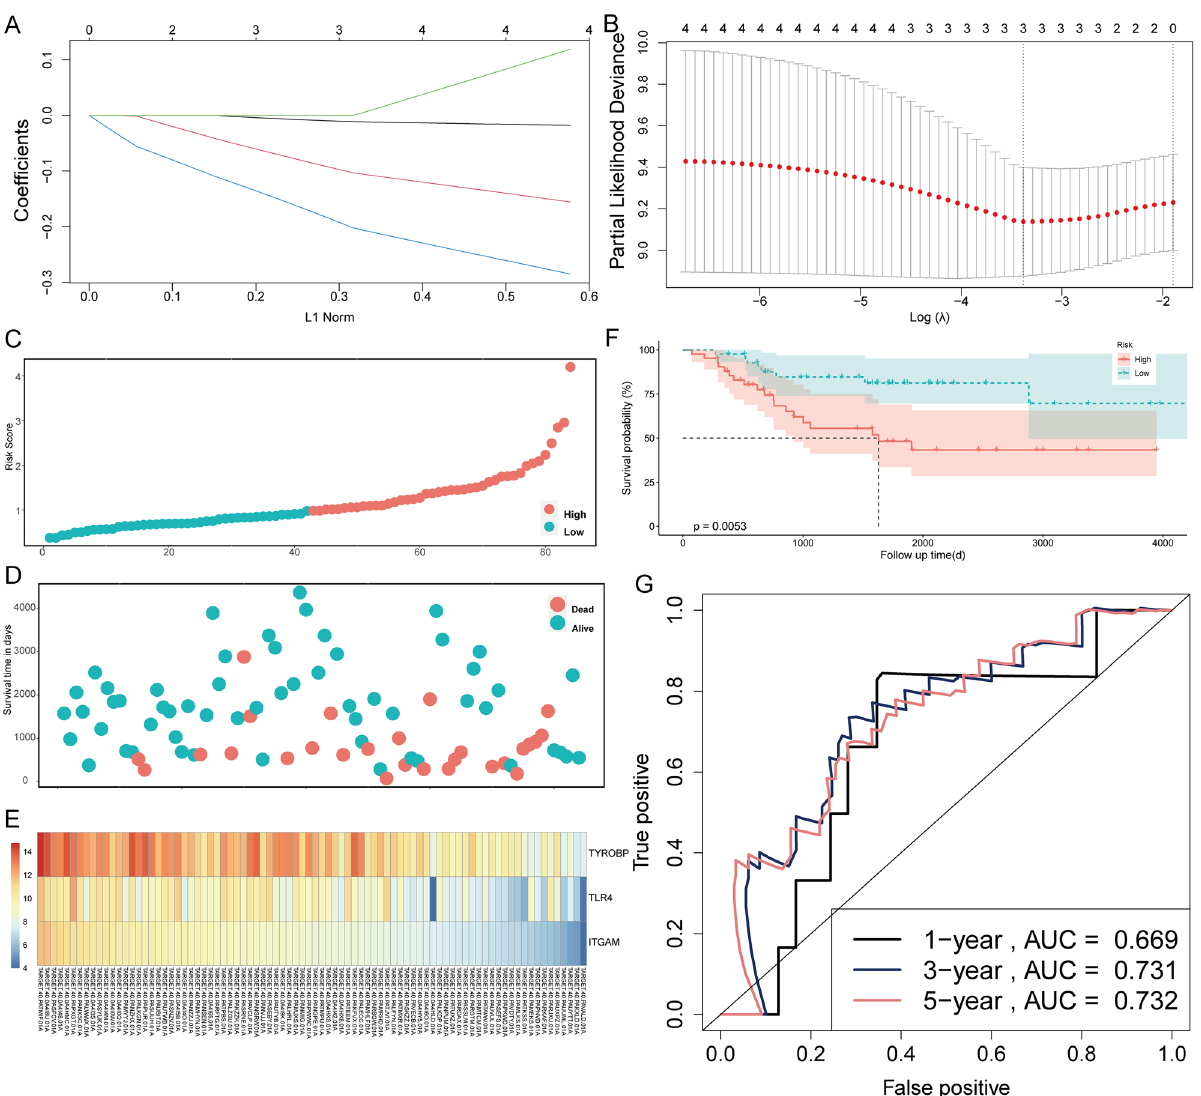
Figure 2. Establishment of a prognostic gene signature for osteosarcoma. ( A ) Using 1000-fold cross-validation to the optimal penalty parameter lambda. ( B ) LASSO coefficient profiles of the 4 DEGs. ( C ) Classification of patients into different risk groups based on the median risk score. ( D ) Distribution of patients’ survival time and status. ( E ) Heatmap of expression profiles of included risk score related genes. ( F ) Kaplan–Meier survival curves between low- and high-risk groups. ( G ) ROC curves of the risk score diagnostic